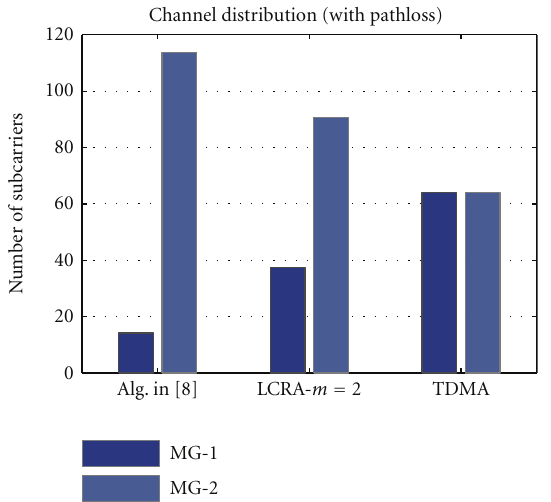
Figure 16: Channel distribution—pathloss di ff erence between